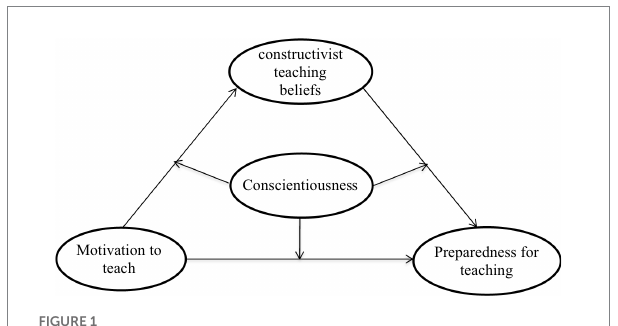
FIGURE 1 A concept model of the mediated